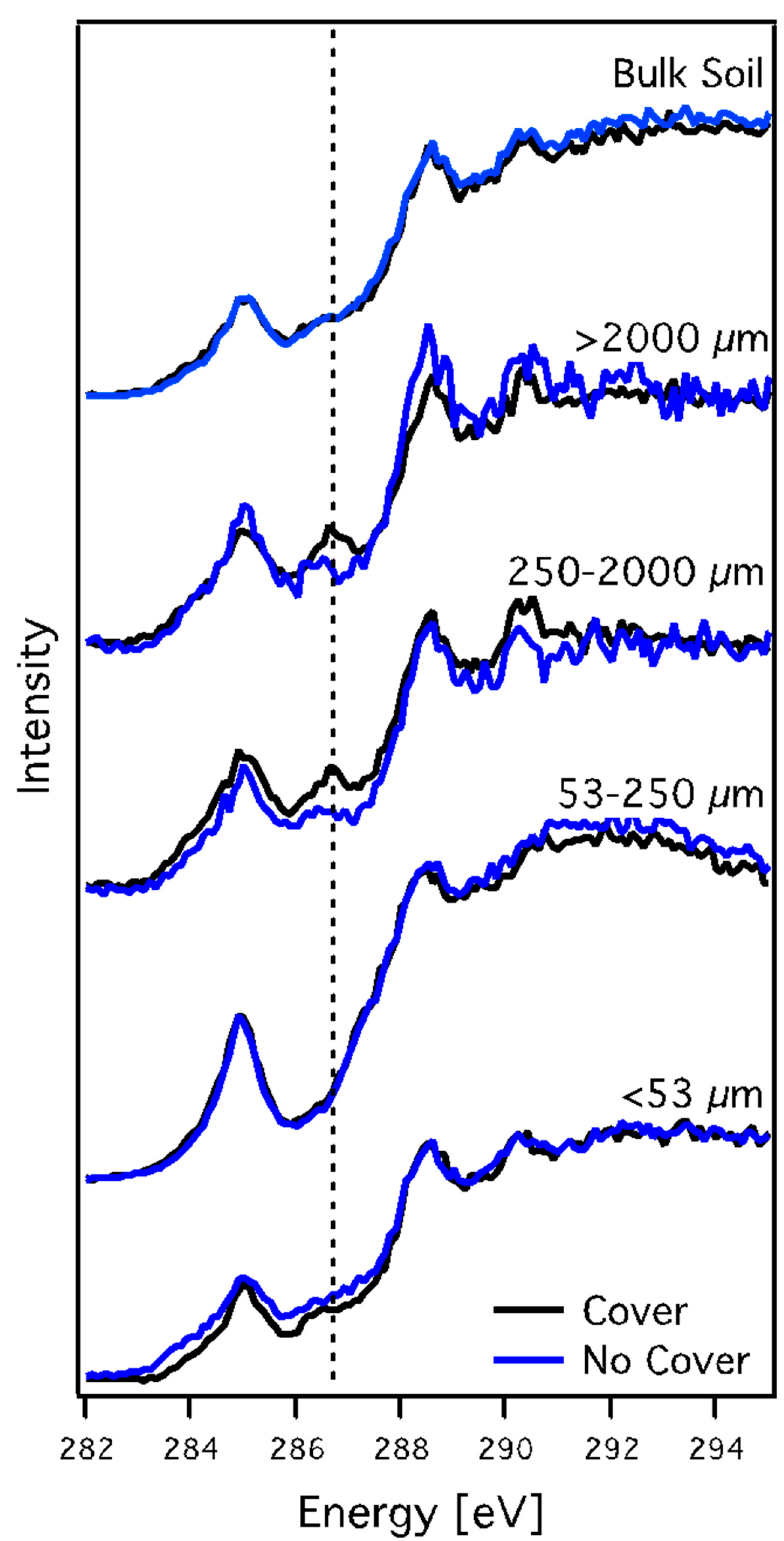
Figure 2. Carbon NEXAFS spectra of bulk soil and size-separated aggregates from soil with (black lines) and without (blue lines) cover crop. Dashed line at 286.7 eV highlights the more intense and shifted phenolic peak in macroaggregates from cover crop soil.